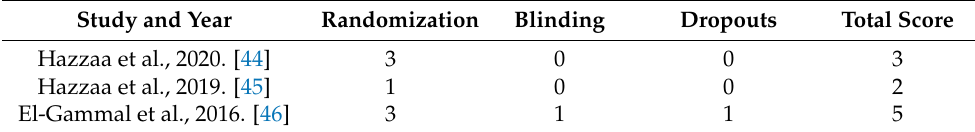
Table 4. Jadad quality score of randomized controlled trial, included in the meta-analysis.